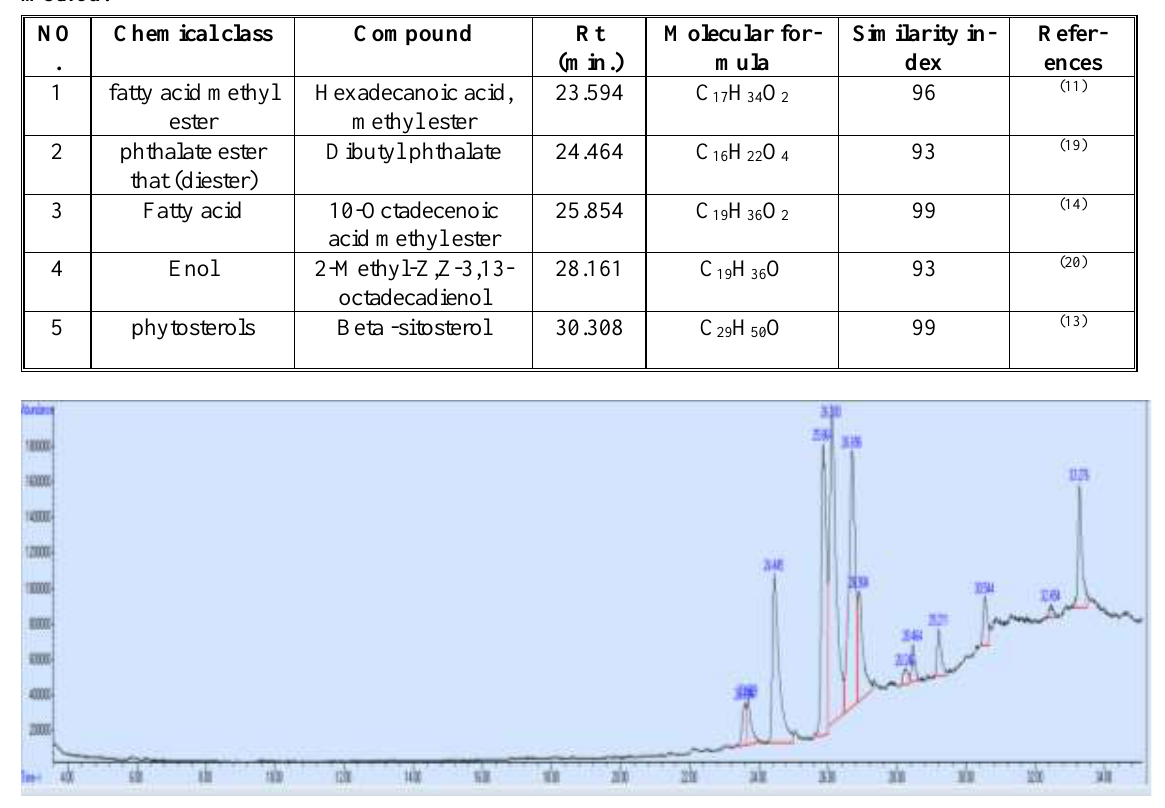
Table 6. GC-MS analysis of petroleum ether stems extract of Leucaena leucocephala by hot extraction method.